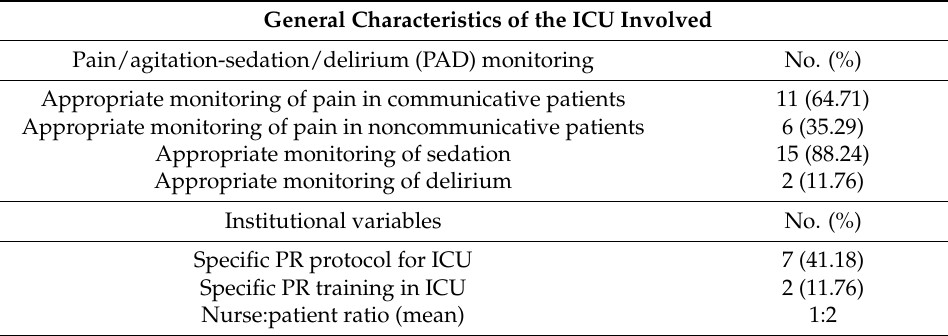
Table 6. Characteristics of the ICU involved in the clinical audit stage. General Characteristics of the ICU